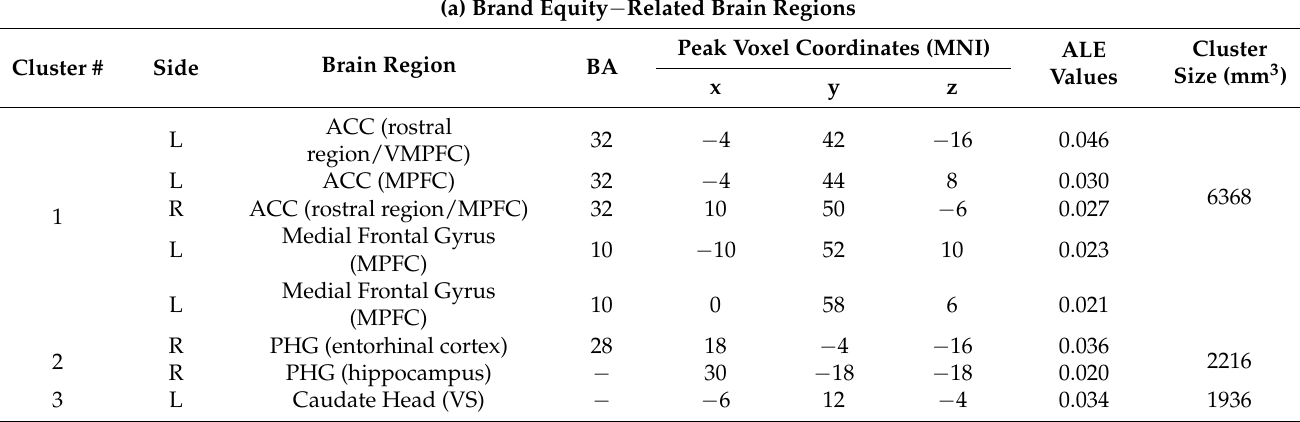
Table 2. Results of